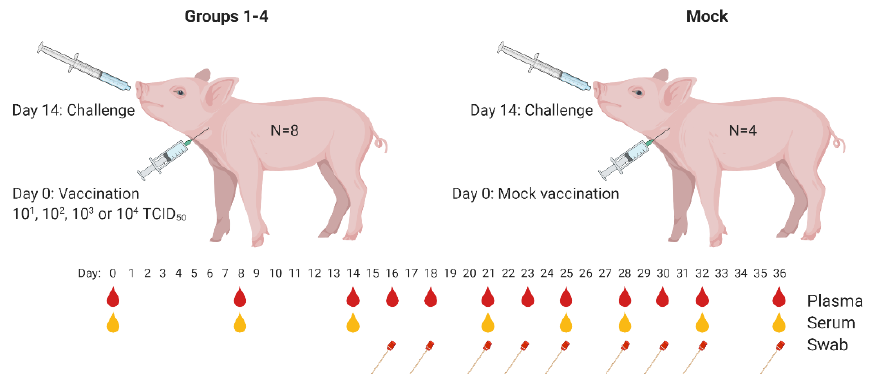
Figure 1. Experimental outline and procedures. Plasma samples (red droplets) were used for detection of viral RNA and serum (yellow droplets) for detection of antibodies by ELISA and neutralization assay. Swabs were used for detection of viral RNA by RT-qPCR. Cartoon created with BioRender.com.